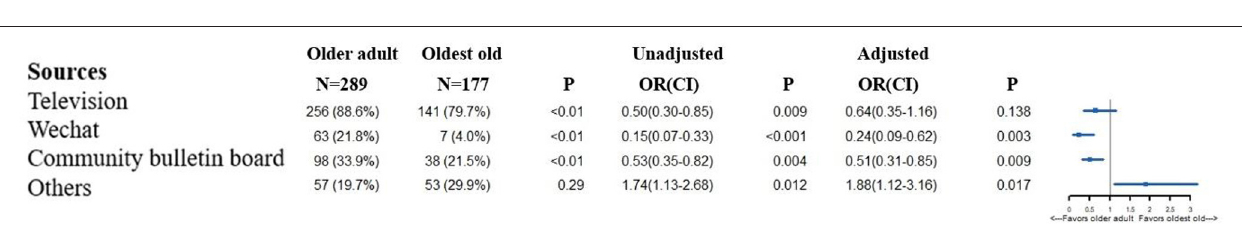
FIGURE 6 | Differences in the sources of acquiring stroke-related knowledge between older adults and the oldest old (age cut-off 75 years). OR, Odds Ratio; CI, Confidence Interval. In the multivariable logistic regression analysis, we adjusted gender, educational background, smoking history, drinking habit, hypertension, diabetes, myocardial infarction, prior stroke, dyslipidemia, cancer history, atrial fibrillation. The OR means the comparison between the older adults and oldest old (oldest old vs. the older